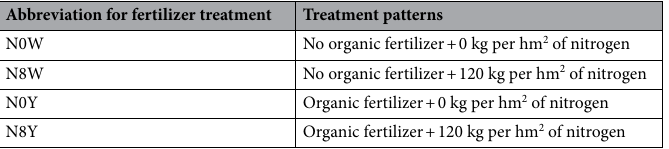
Table 1. Abbreviations of different fertilizer treatments and corresponding fertilizer application